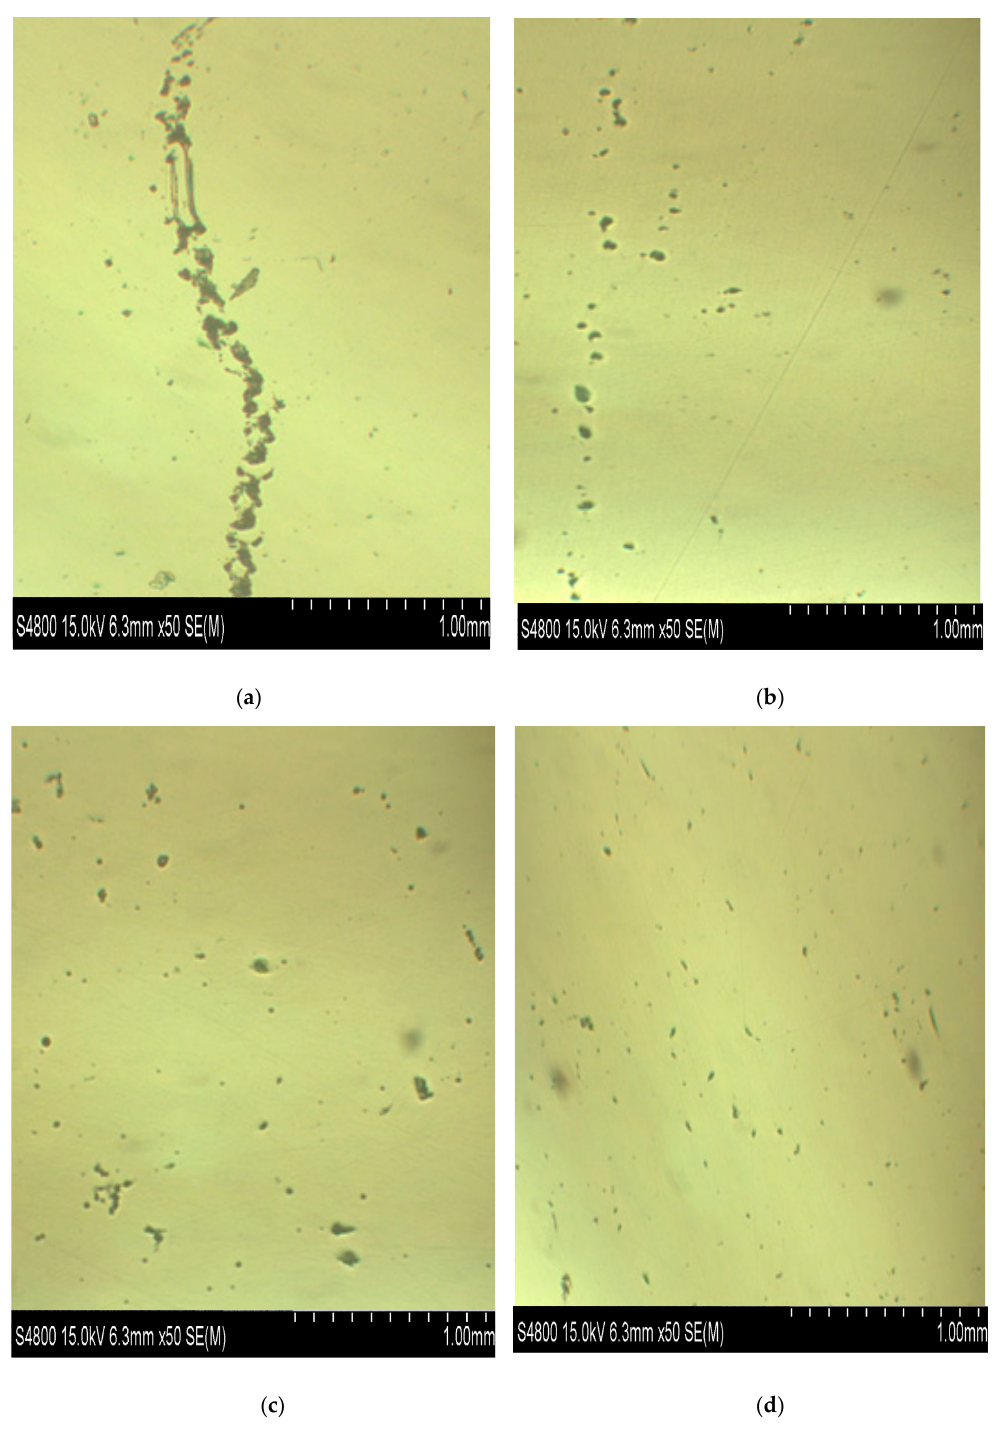
Figure 10. ( a , b ) Microstructure of sample indicating alumina-type inclusions, as per ASTM E-45, ( c , d ) Microstructure of sample indicating oxide-type inclusions, as per ASTM E-45.